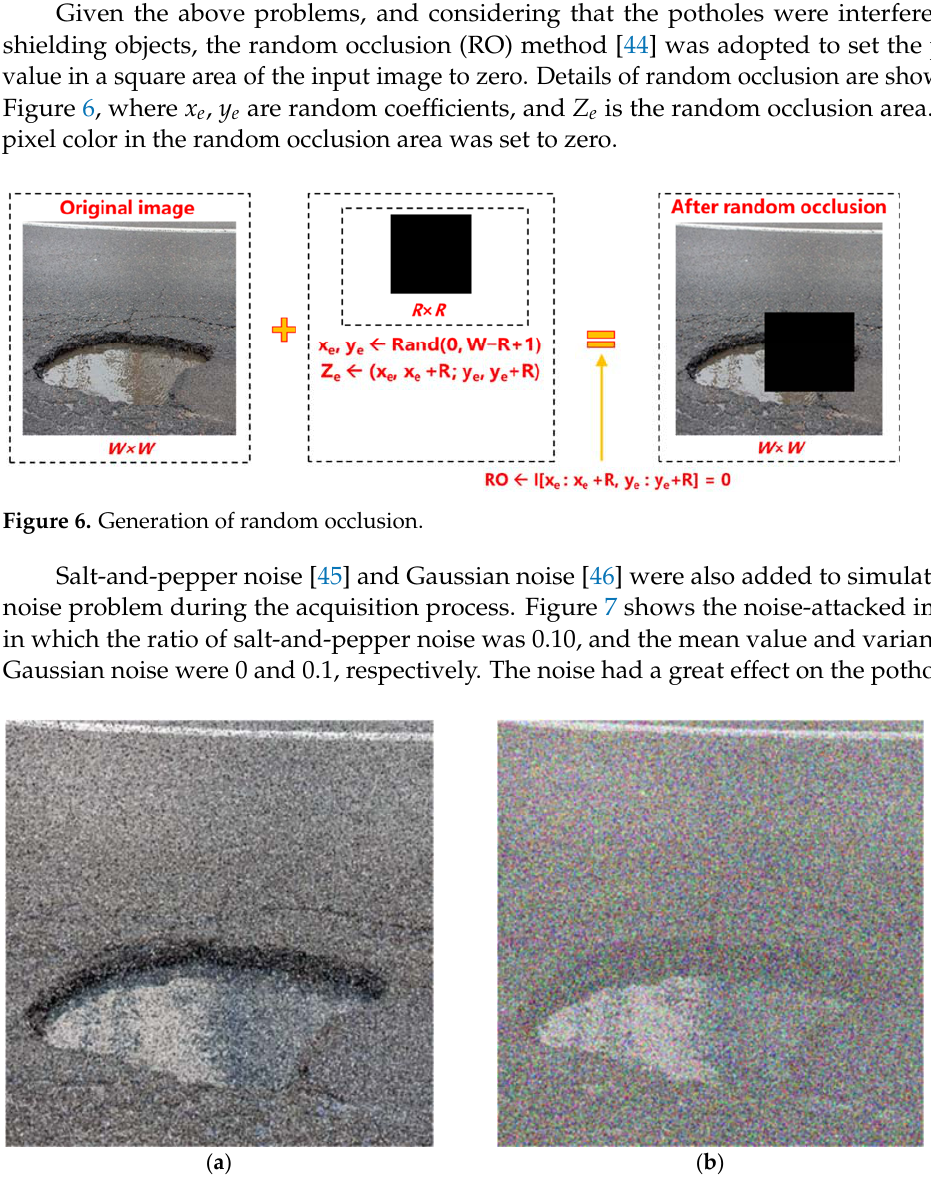
Figure 7. Pothole image after adding noise: ( a ) salt-and-pepper noise; ( b ) Gaussian noise.